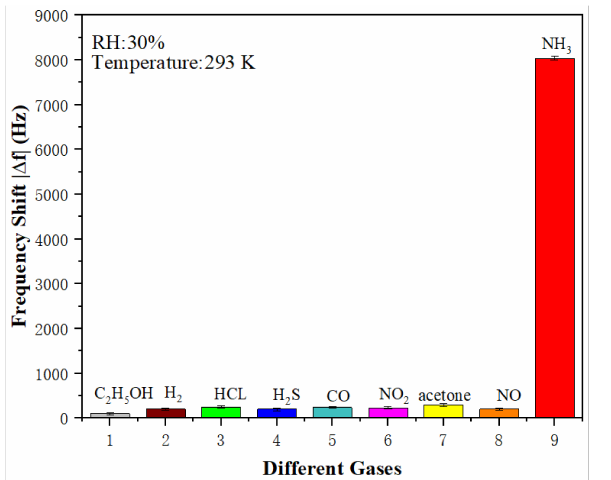
Figure 9. The absolute value of frequency shifts of PAA SAW ammonia sensor to different types of gases of 20